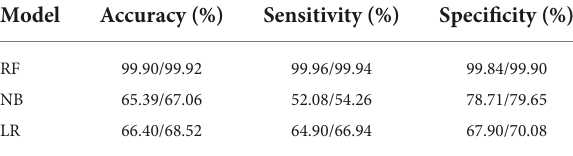
TABLE 3 Performance evaluation of the three classifiers on the training set (GI/TI).